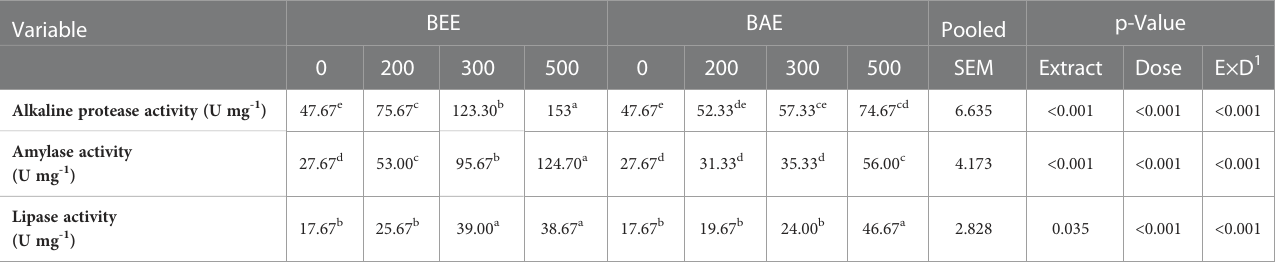
TABLE 3 Effect of dietary supplementation of basil ethanol and aqueous extracts (mg kg -1 of feed) on digestive enzyme activities of Nile tilapia, O. niloticus .